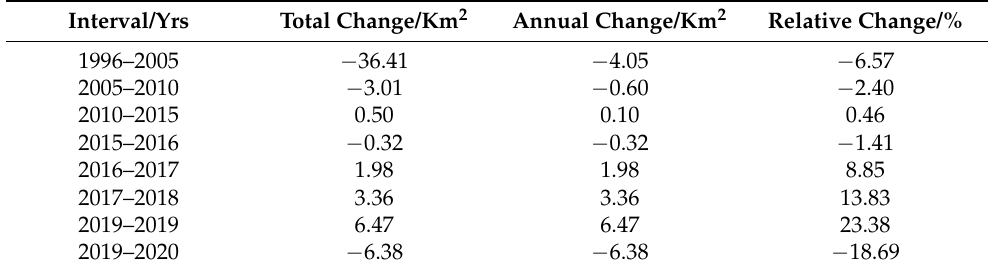
Table 2. The change characteristics of the water surface area of Eichmann Lake from 1996 to